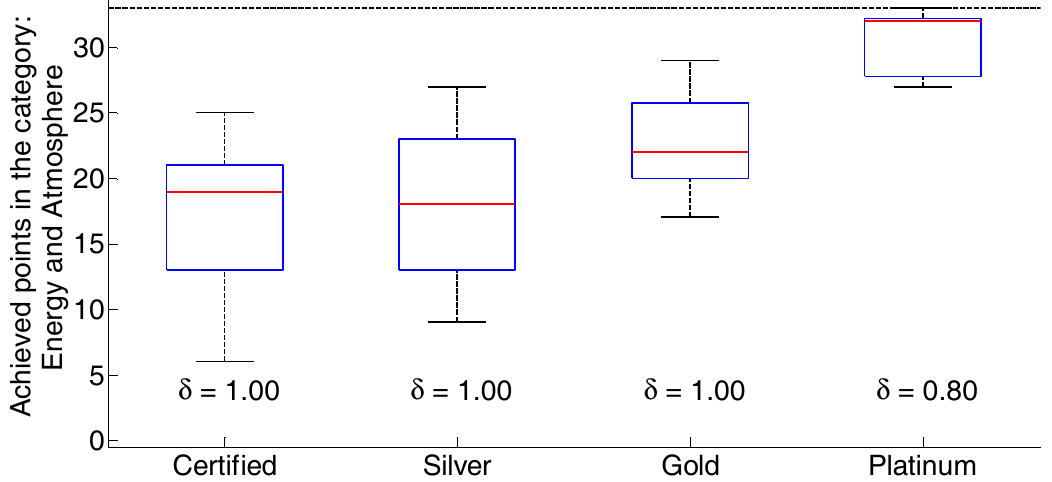
Figure 5. The boxplot results and Cliff’s δ effect size between possible and achieved points in the Energy and Atmosphere category. Effect size is considered to be: very high if | δ | < 0.147 (bold font), high if 0.147 < | δ | < 0.33 (bold italic font), medium if 0.33 < | δ | < 0.474 (italic font), and low if | δ | ≥ 0.474 (normal font).